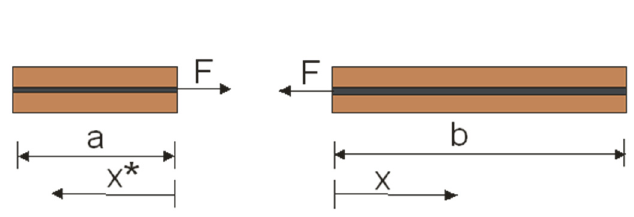
Figure 12. Overview of forces acting on the reinforcing element.